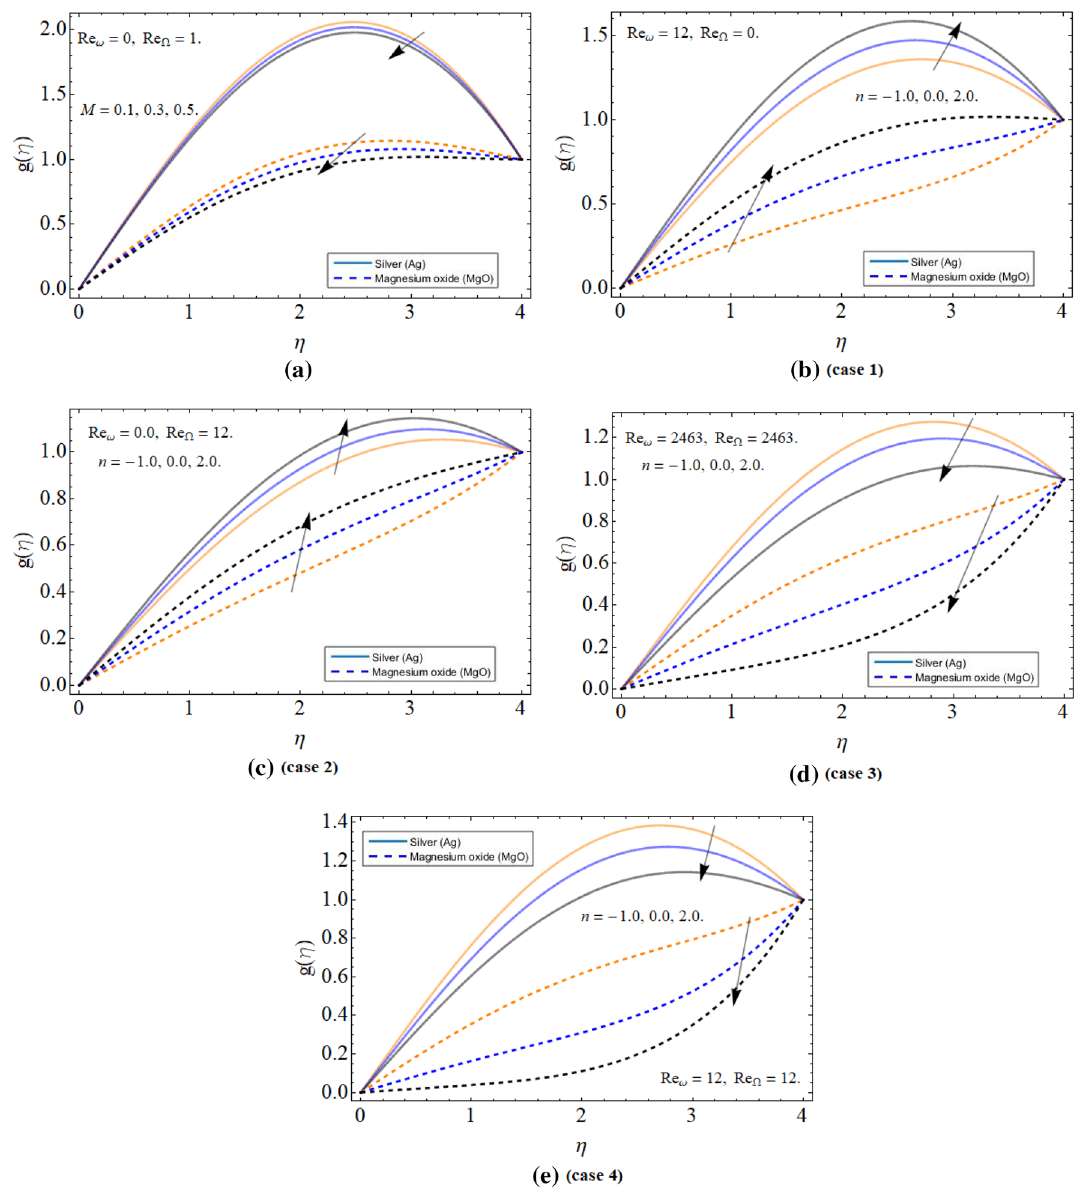
Figure 3. The behavior of radial velocity profile g (η) versus ( a ) magnetic field M ( b ) disk rotation ( c ) cone rotation ( d ) both disk and cone co-rotation ( e ) both disk and cone counter